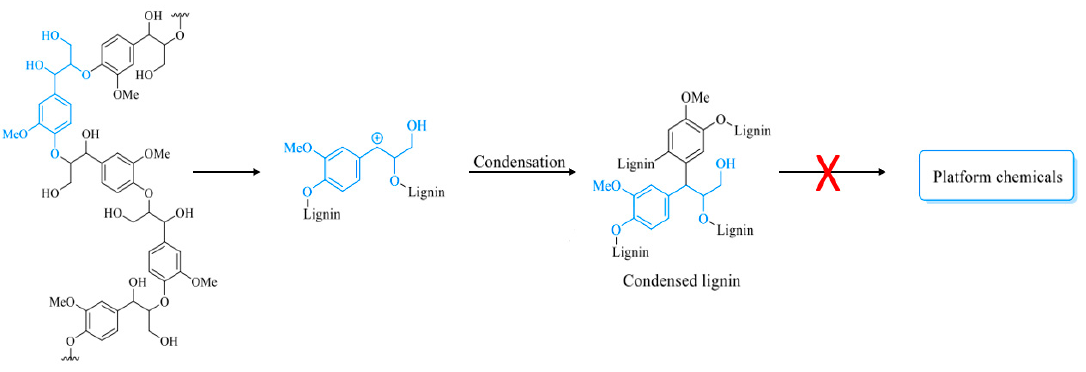
Figure 5. Schematic diagram of lignin condensation.